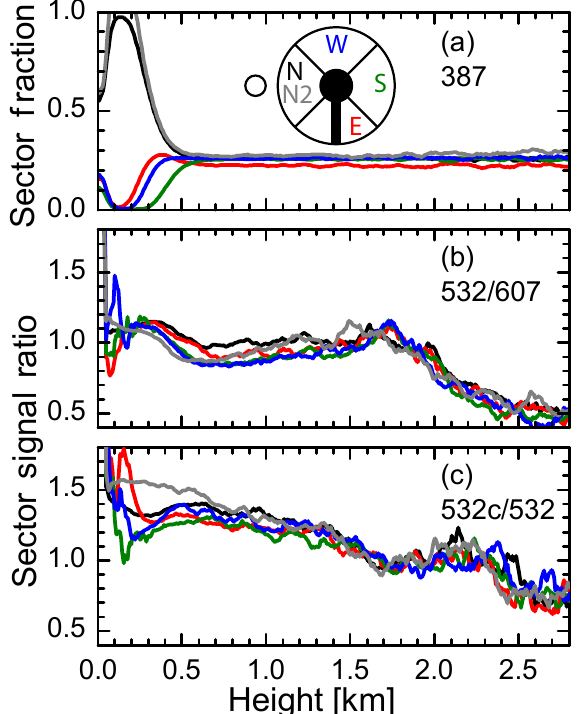
Figure 7. Telecover test measurement of Polly XT _NOA on 25 May 2015. Measurements of 15min duration were taken for each of the telescope sectors (north, east, south, and west with respect to the laser beam) as indicated in (a) . The signals were smoothed for 75m range. The measurement of the north sector was performed twice (N2) with a time difference of 1h in order to account for at- mospheric variability. (a) signal fraction of each sector to the sum of all sectors (N + E + S + W). (b) signal ratios of the 532 and 607nm wavelength channels for each sector. The curves were normalized to 1 between 1.5 and 2km. (c) same as (b) but for the cross-polarized and total channels at 532nm